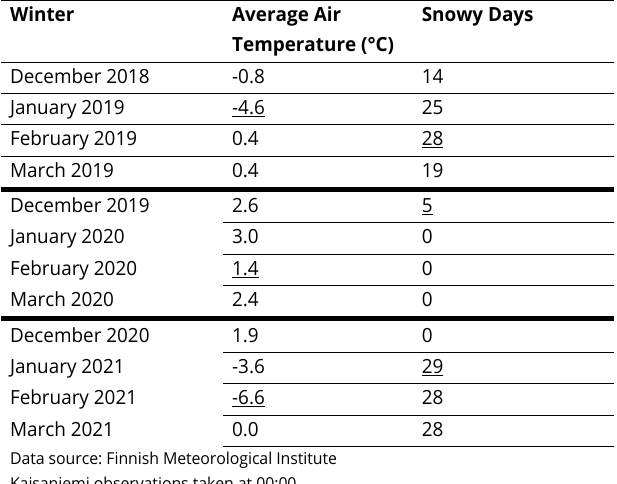
Table 1. Average air temperature and total snowy days in Helsinki for the winters of 2018–2021.